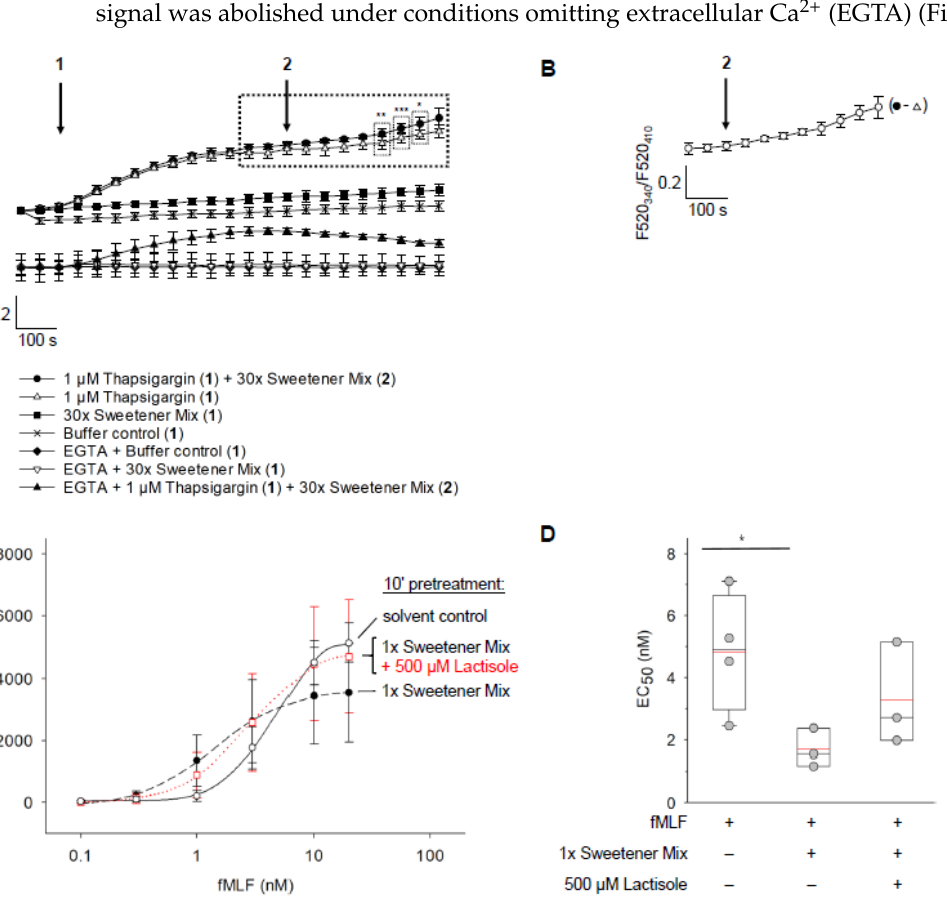
Figure 8. Sweetener-induced facilitation of fMLF-stimulated Ca 2+ signaling in isolated PMNs. ( A ) Sweetener-induced priming effects of freshly isolated PMNs stimulated with 30× sweetener mix. Fluorescence was measured by a spectrofluorometer with dual excitation at 340 nm and 410 nm, and emission at 520 nm. Arrows indicate application times (“1”: 2 min; “2”: 10 min). The fluores- cence ratio F520340/F520410 was calculated and normalized to the initial ratio at 0 s. Data points represent mean ± SD ( n = 3). * p = 0.032; ** p = 0.008; *** p < 0.001 (paired, two-tailed Student’s t -test). ( B ) Shown is a 30× sweetener-induced increase in Ca 2+ influx as kinetic of ratio F520340/F520410 in the presence of 1 μM thapsigargin and 30× sweetener mix after subtraction of ratio F520340/F520410 in the presence of 1 μM thapsigargin only from ( A ). Data are mean ± SD ( n = 3). ( C ) fMLF-induced concentration-response relations of pre-stimulated PMNs under varying conditions. Cells were pre- stimulated with 1× sweetener mix or solvent control for 10 min followed by the addition of fMLF at concentrations ranging from 0.1 nM to 20 nM. To test for an inhibition of a TAS1R2/TAS1R3-medi- ated effect of the 1× sweetener mix on the fMLF concentration–response relation, lactisole (500 μM) was added to the sweetener mix during pre-stimulation of cells. Sweeteners and lactisole were pre- sent during fMLF stimulation. Fluorescence was measured until 10,000 events were obtained by fluorescence-activated cell analysis using 494 nm excitation and 506 nm emission. A total of 0.1% DMSO was used as solvent control and subtracted from each measurement, using 5% to gate posi- tive signals. Data are mean ± SD ( n = 3, n = 4 for fMLF). ( D ) EC 50 values derived from ( B ) are dis- played as box plots with medians (black horizontal lines) and calculated means (red horizontal lines); * p = 0.045 (two-tailed Student’s t -test).